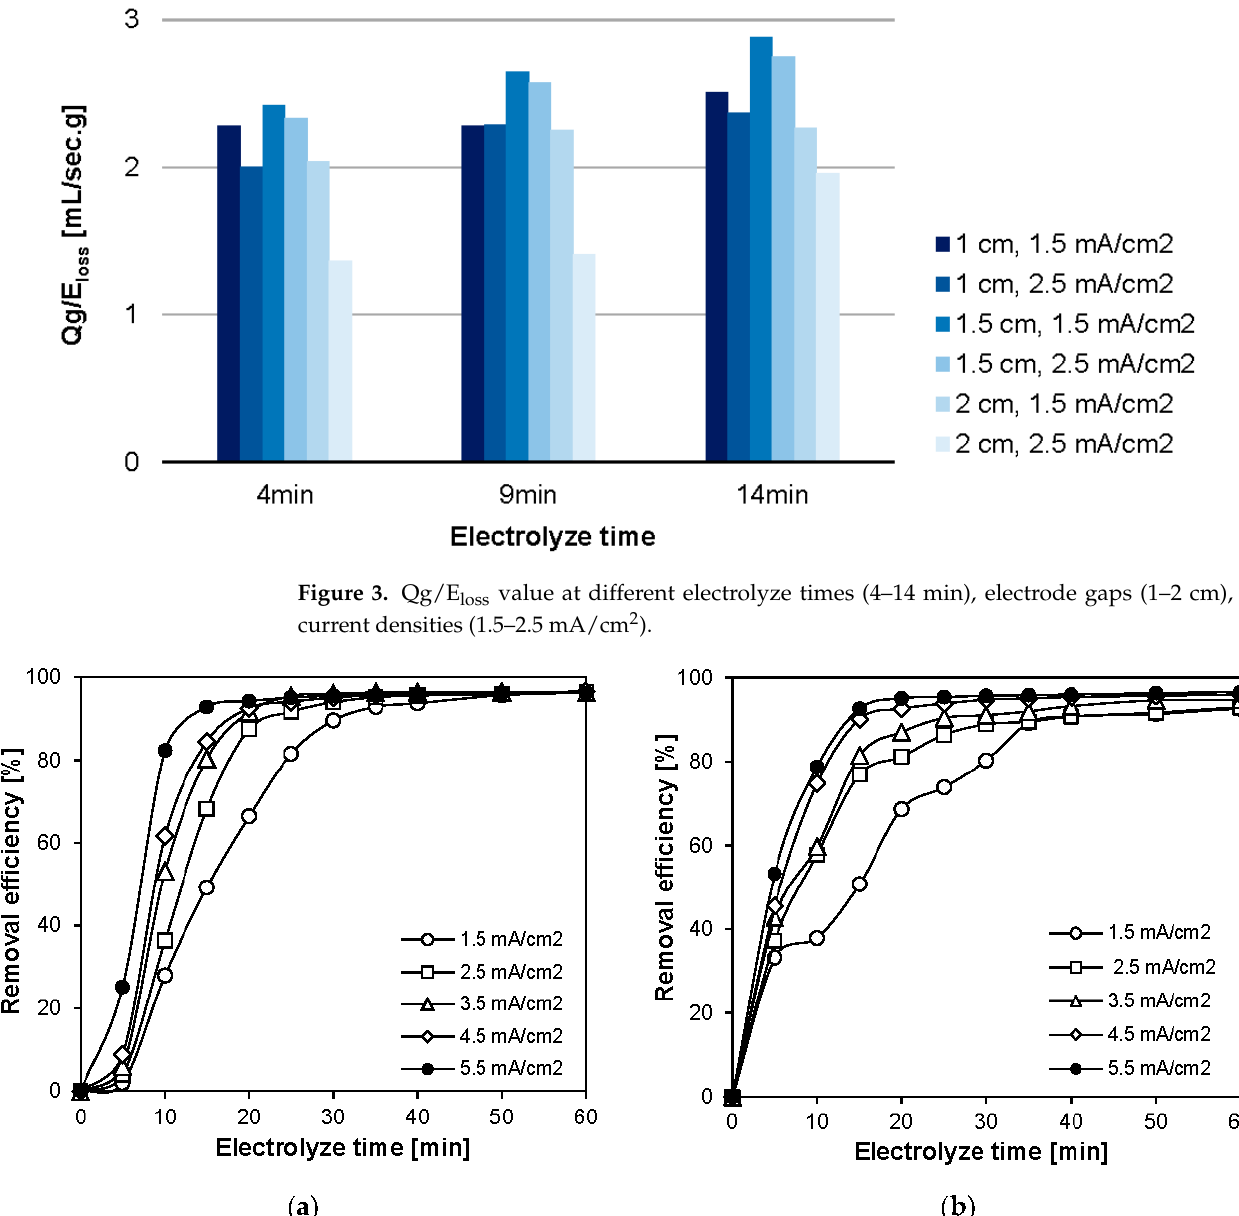
Figure 4. Effect of current density on removal efficiency of ( a ) turbidity and ( b ) color.